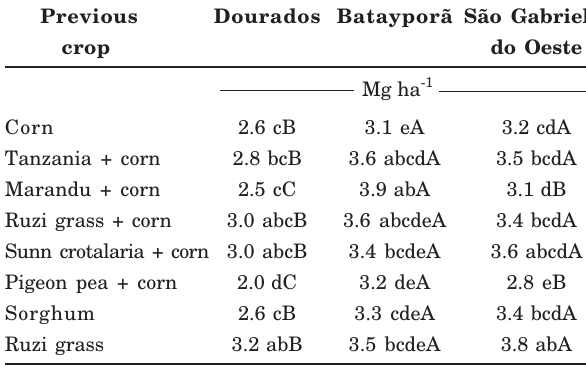
Means followed by the same lowercase letter in a column, and by the same uppercase letter in a row are not significantly different by the Tukey test (p 0.05).